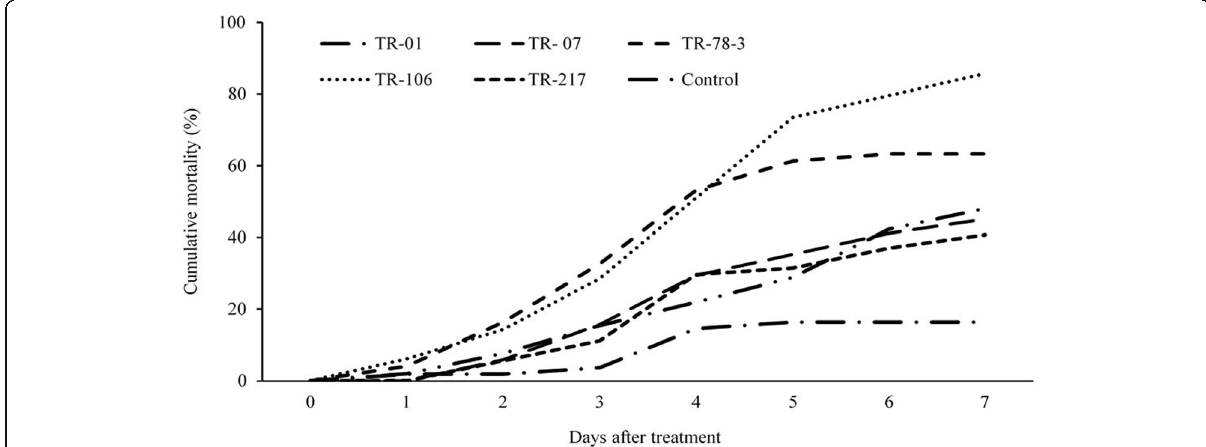
Fig. 3 Mortality rate of Sitophilus granarius treated with entomopathogenic fungi at 20